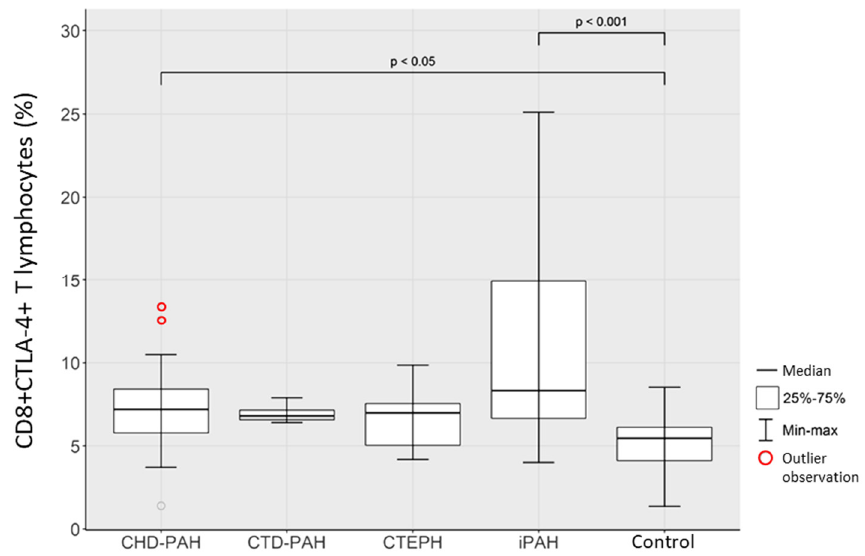
Figure 3. Percentage of CD8+CTLA4+ T lymphocytes in CHD-PAH, CTD-PAH, CTEPH, iPAH patients and control subjects. Comparison of the percentage of CD19+CTLA4+ B lymphocytes in selected types of PAH and in the control group revealed a significantly higher percentage of these